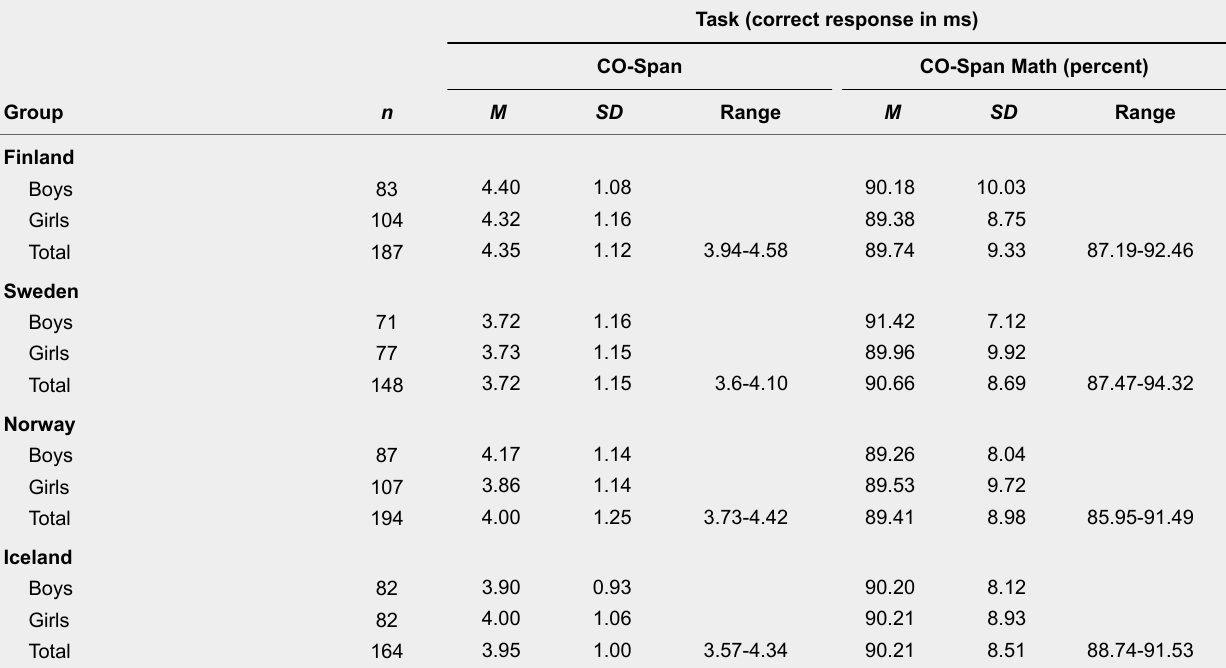
Task (correct response in ms) CO-Span CO-Span Math (percent) n M SD Range M SD